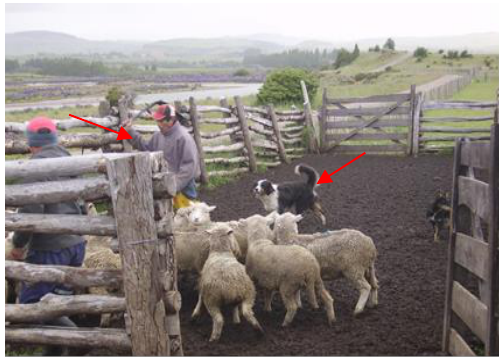
Figure 2. Moving sheep with dogs and other driving aids.